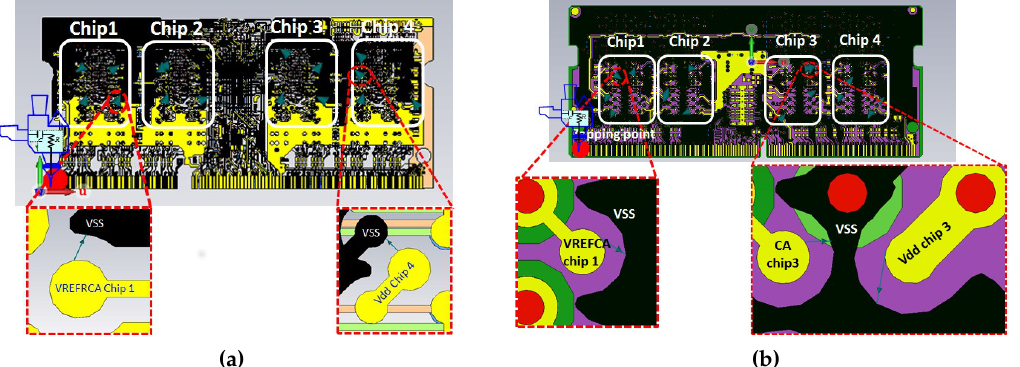
Figure 11. Installed voltage monitors (VMs) across difference trace of memory module for measuring induced ESD noise voltages: ( a ) DDR3; and ( b )